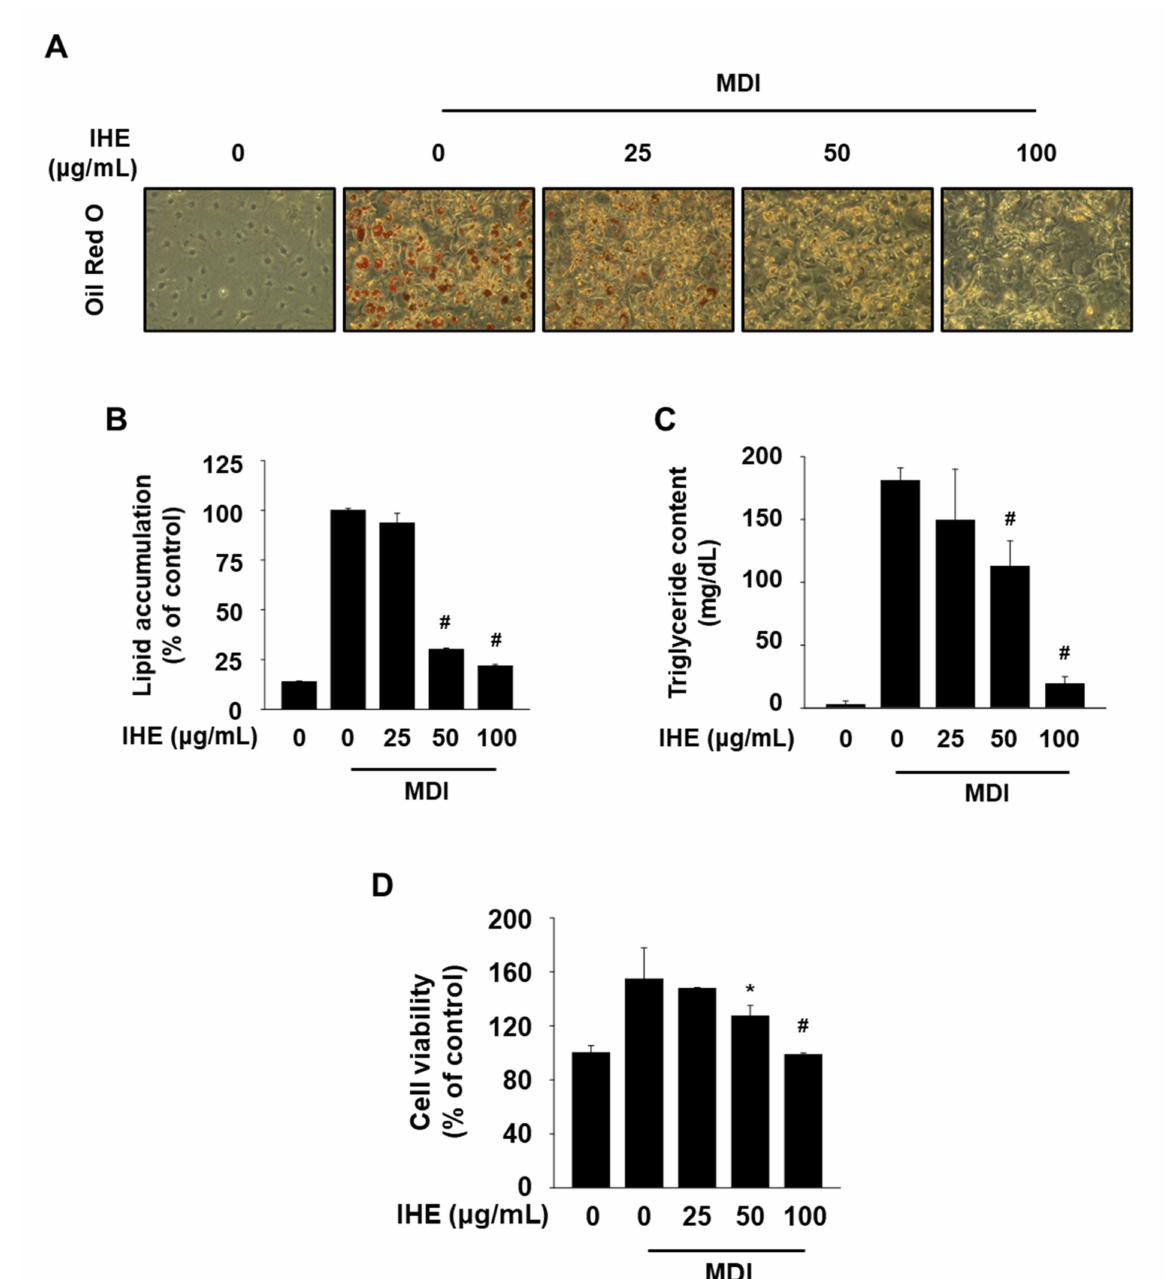
Figure 4. Effect of IHE on MDI-induced adipogenic differentiation of 3T3-L1 cells. ( A – C ) Cells were treated with IHE for 7 days in the presence of MDI and then intracellular lipid accumulation and TG content were measured. ( D ) Cell viability was measured at 7 days by an MTT assay; * p < 0.05, # p < 0.001 vs. MDI